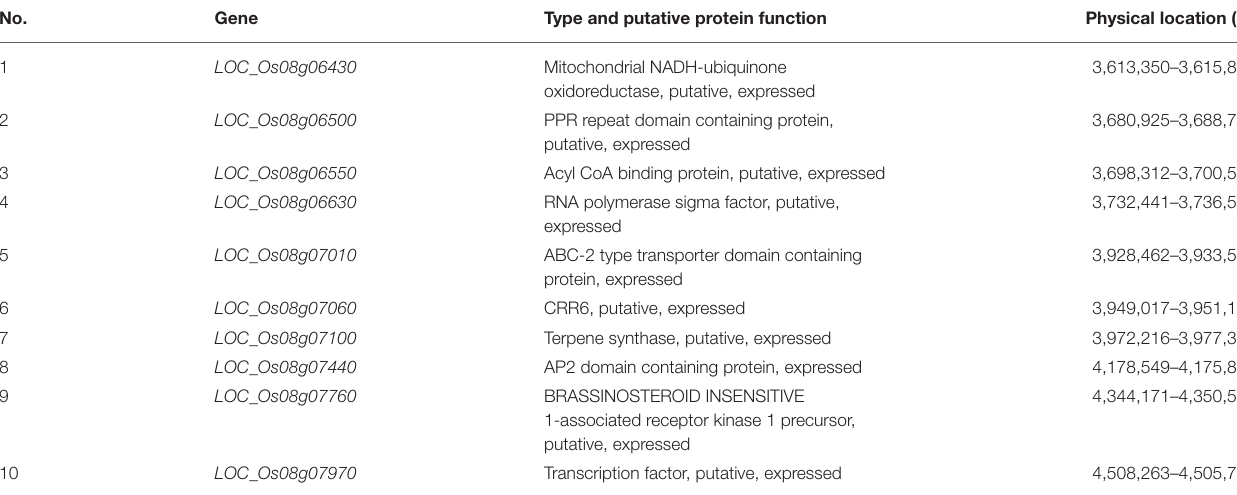
TABLE 3 | Putative genes associated with abiotic stress tolerance in the qHTT8